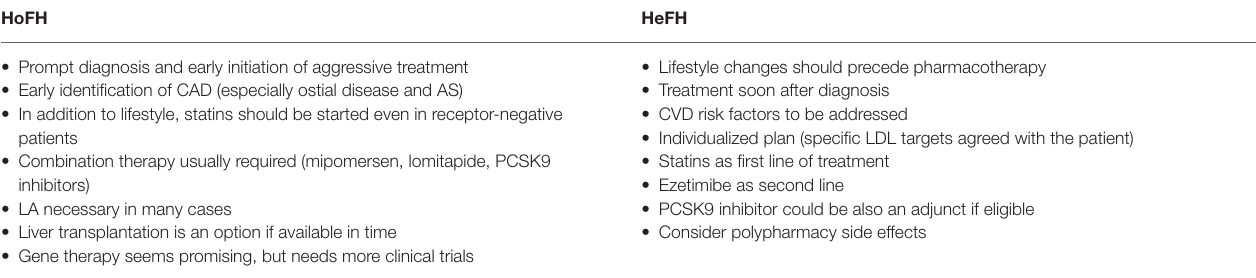
TABLE 12 | Key points for HoFH and HeFH treatment (Goldberg et al., 2011; Catapano et al., 2016; Jellinger et al., 2017). HoFH